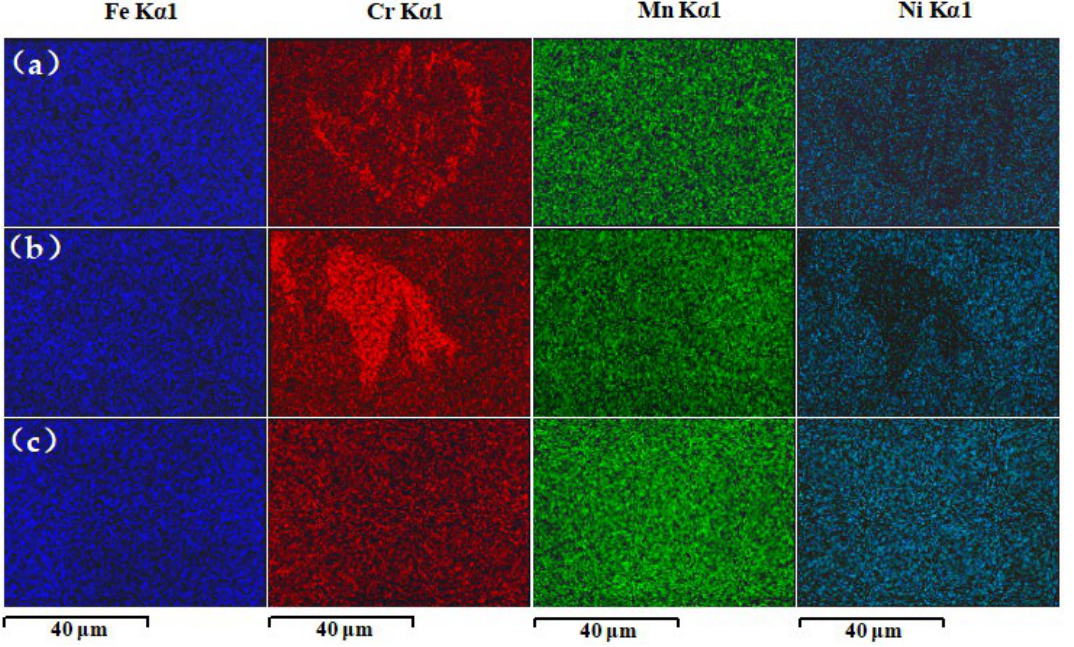
Figure 4. Elemental distribution pattern of as-cast and heat treated FeCrMnNi alloys ( a ) as-cast ( b )